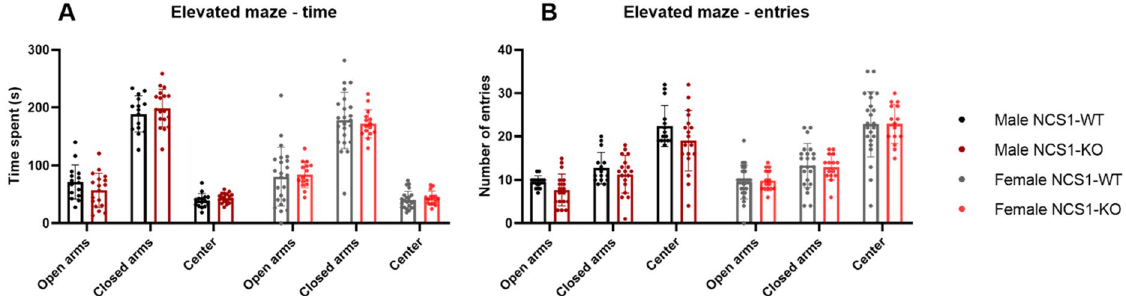
Figure 6. NCS1-WT and -KO mice exhibit no differences in Elevated Plus Maze. ( A ) Both male NCS1-KO and male NCS1-WT mice spent the same amount of time exploring open and closed arms as well as the center (2-way ANOVA, Factor genotype, p > 0.99). The same applies to females (2-way ANOVA, Factor genotype, p = 0.43). ( B ) No difference in the number of entries to the different sections was observed between the groups [2-way ANOVA, Factor genotype (male), p = 0.13; 2-way ANOVA (female), Factor genotype, p = 0.99]. Error bars show ± SD. Male NCS1-WT: n = 15, male NCS1-KO: n = 18, female NCS1-WT: n = 15, female NCS1-KO: n = 23.